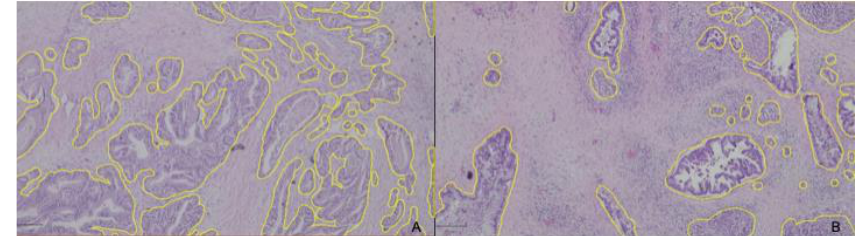
Figure 2. PDAC with a lower TSA ( A ) and a higher TSA ( B ). Yellow lines were used to determine the TSA by subtracting the glandular area from the total area, using the software QuPath-0.2.3. The ROC curve analysis did not show statistically significant results for TSA, so it was not possible to identify cutoff values to predict OS [area under the curve (AUC) 0.544;